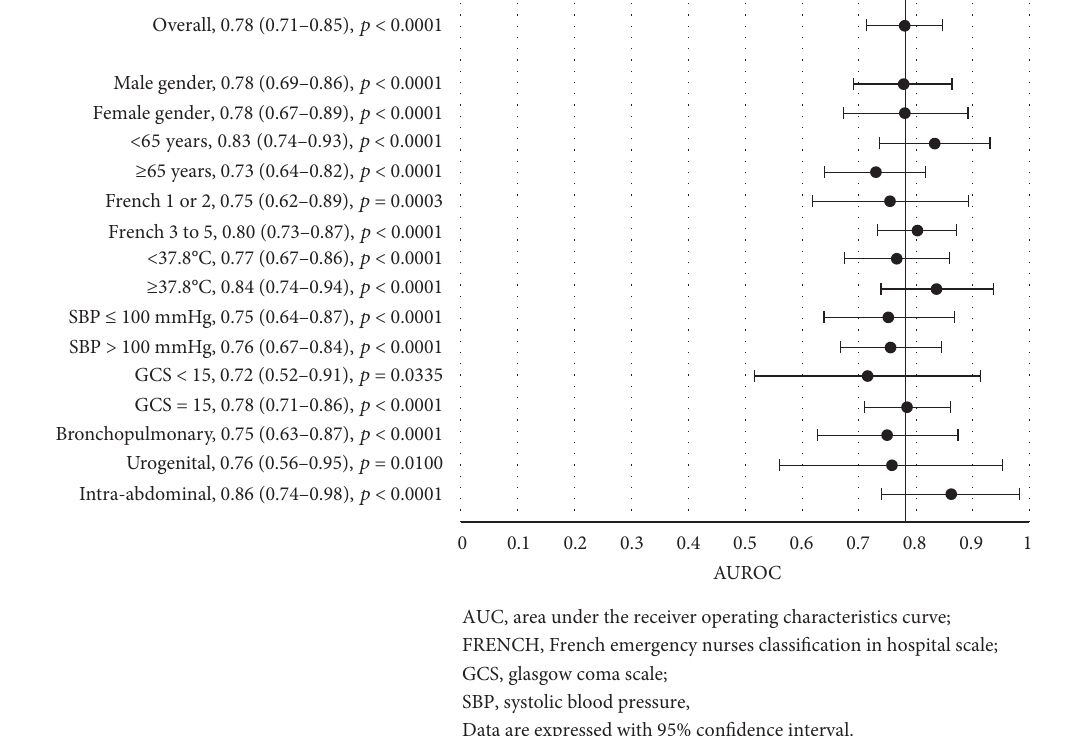
Figure 4: Forest plot of the area under the receiver operating characteristics curve for procalcitonin discrimination in septic shock, stratified by different